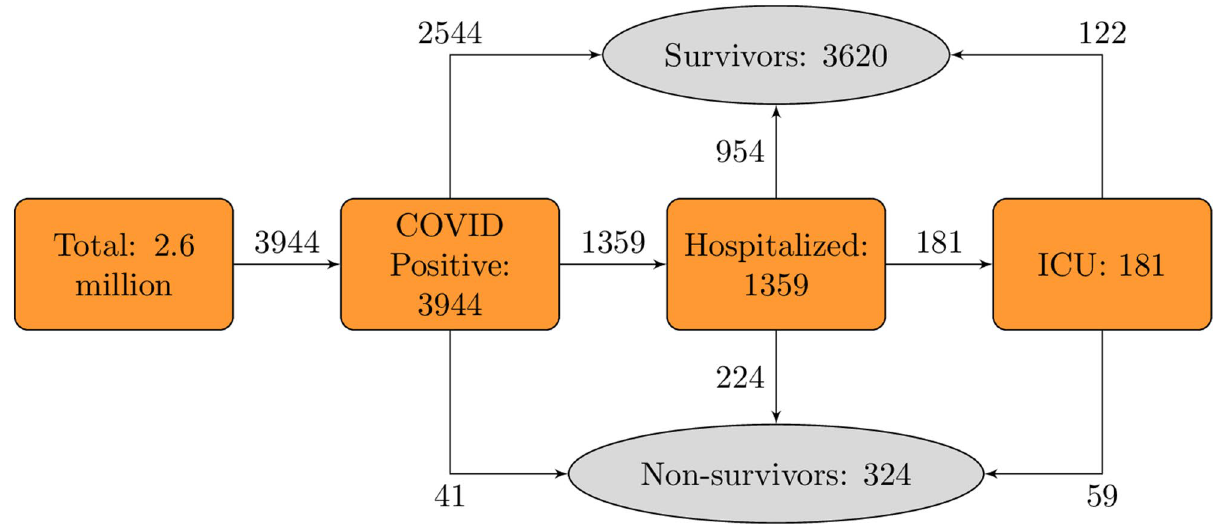
Figure 1. Flowchart of patient selection and identification for the Danish cohort. ICU intensive care unit.